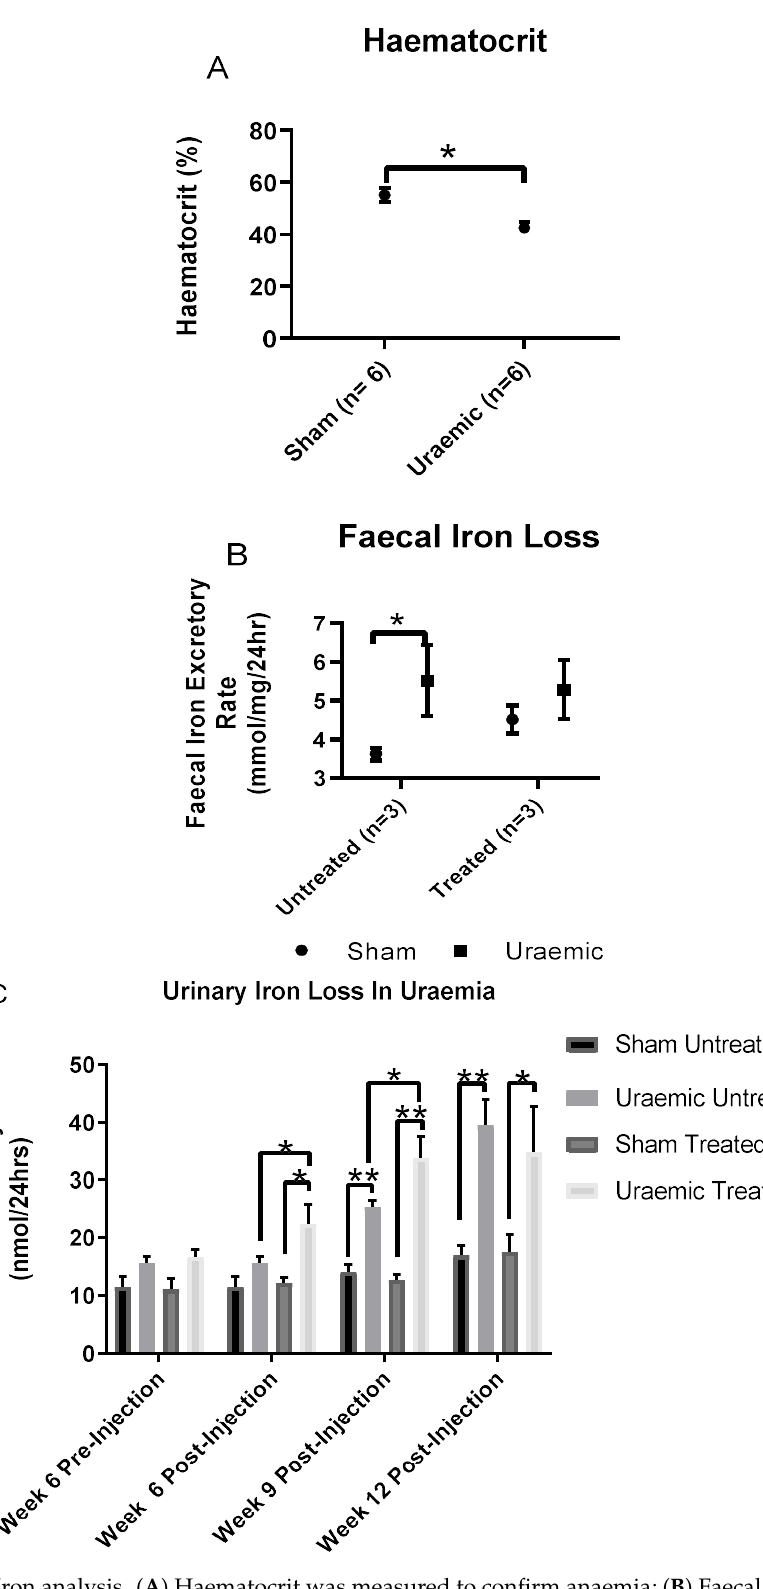
Figure 3. Iron analysis. ( A ) Haematocrit was measured to confirm anaemia; ( B ) Faecal Iron loss as a measure of iron malabsorption; ( C ) Urinary iron excretion was evaluated to study the cause of iron deficiency. Data are presented as mean ± SEM (* p < 0.05, ** p < 0.01).